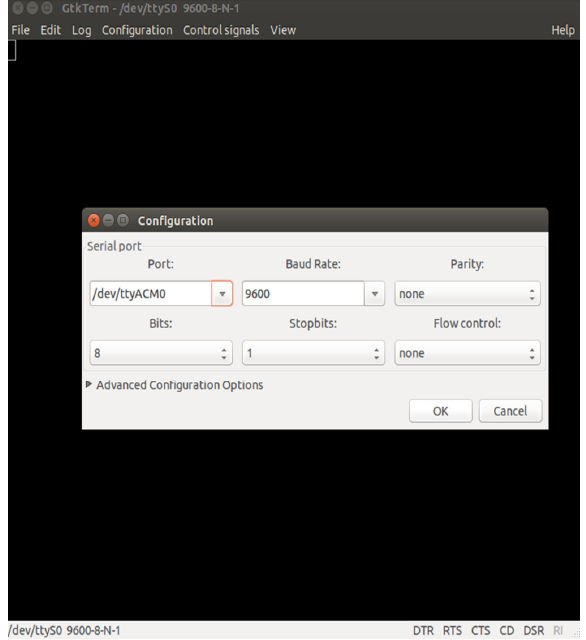
Figure 7. Connecting Zodiac FX